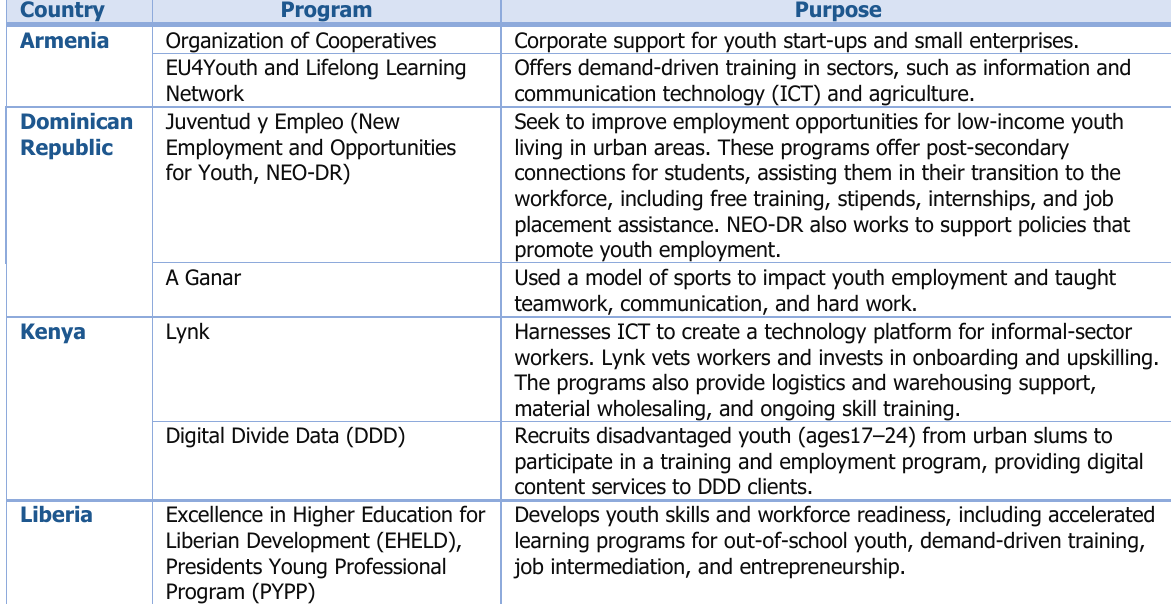
Table 5: Exemplar Programs Building Youth Employability